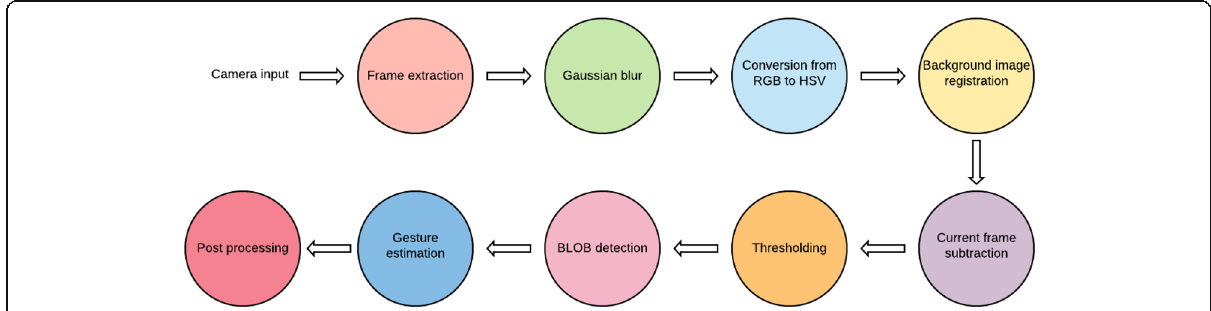
Fig. 12 Working of virtual trial room based on steps mentioned in ref.